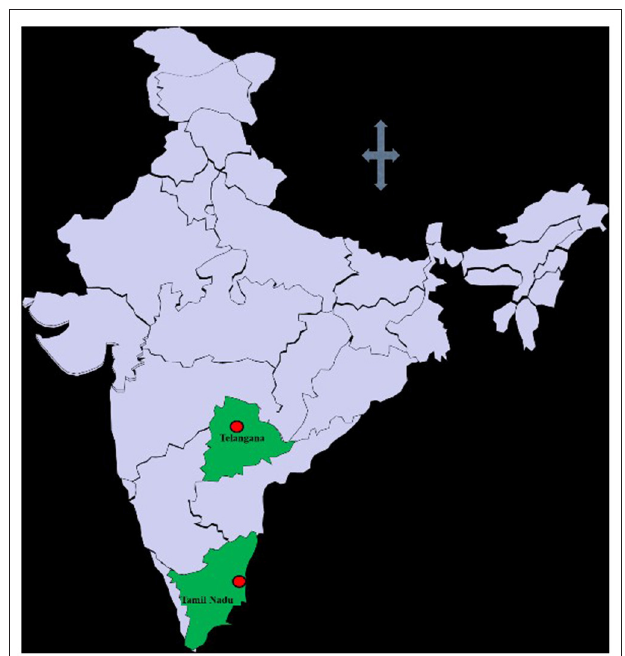
FIGURE 2 | The research sites in Telangana and Tamil